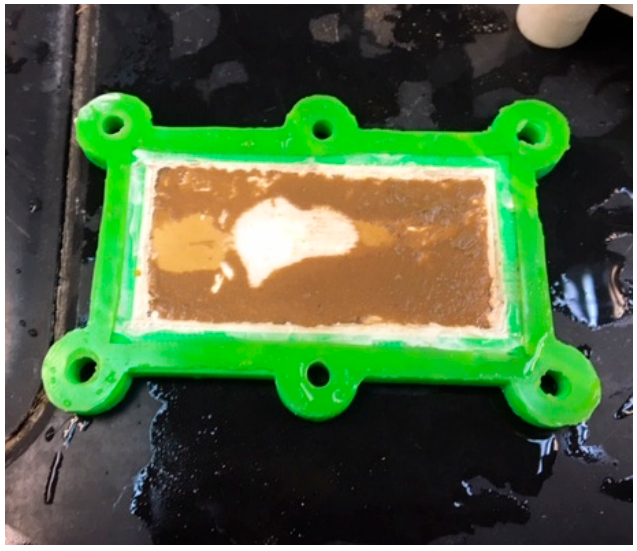
Figure 9. Waste residues on monolith surface upon completion of wastewater filtration.